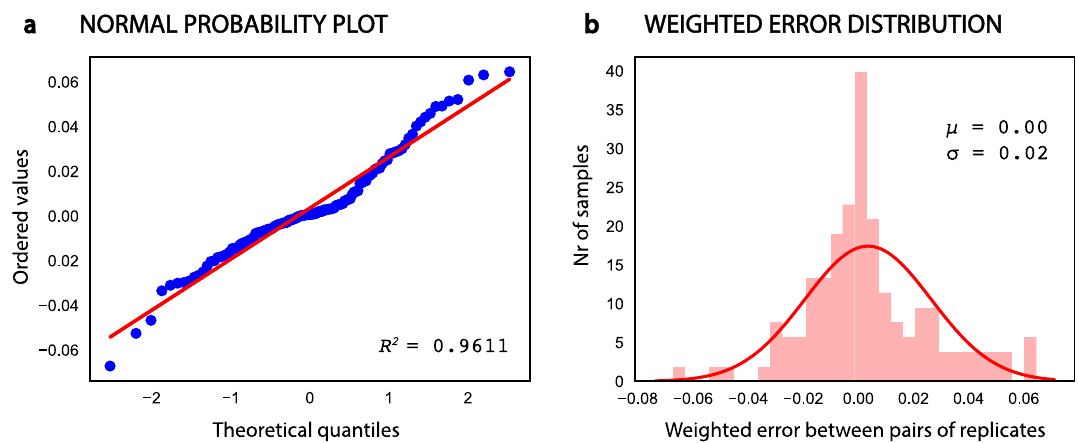
Figure 3. Analysis of the error between replicates of the flow cytometry data. ( a ) normal probability plot of the experimental data. The red line represents an ideal normal distribution. The high R 2 coefficient of the experimental data with the red line indicates that the weighted errors are nearly normally distributed. ( b ) Weighted error distribution, where µ is the mean value of the distribution and σ is the standard deviation. The red line shows the normal distribution fitted to the experimental weighted errors. This figure was produced using Python 70